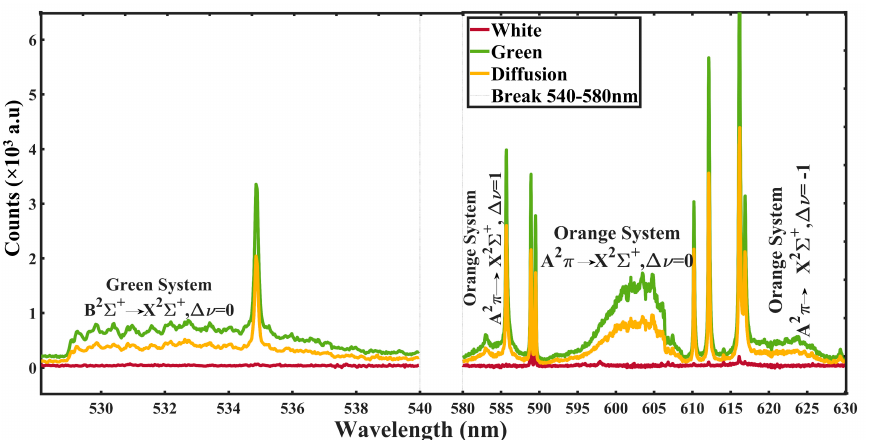
Figure 4. LIBS spectra of the white, diffusion, and green zones of the sample in the wavelength range of 528–630 nm, depicting the molecular bands of CaF (orange and green systems).